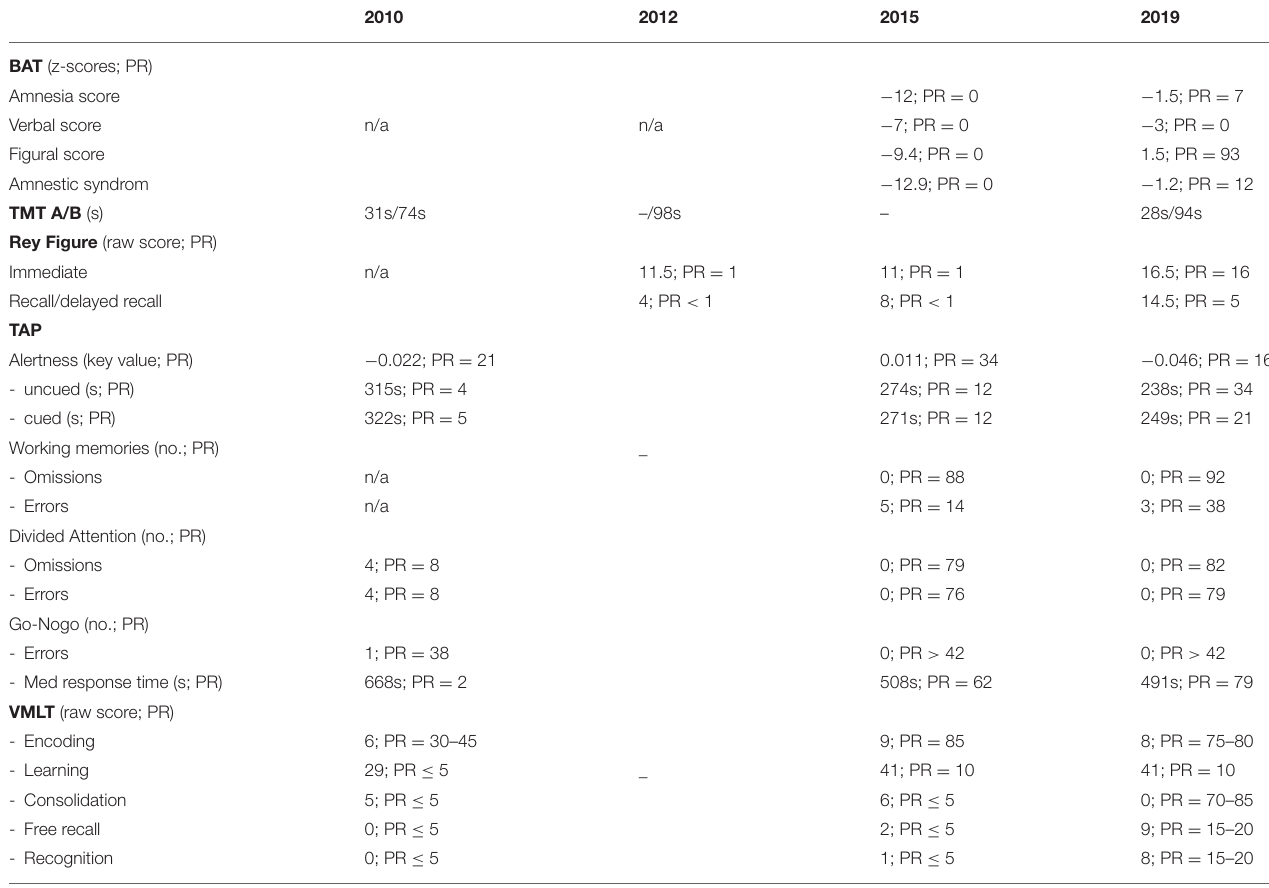
TABLE 1 | Summary of the neuropsychological tests conducted at P.A.N. admission (2010), P.A.N. discharge (2012), 3- (2015), and 7-year follow-up (2019) in the community.